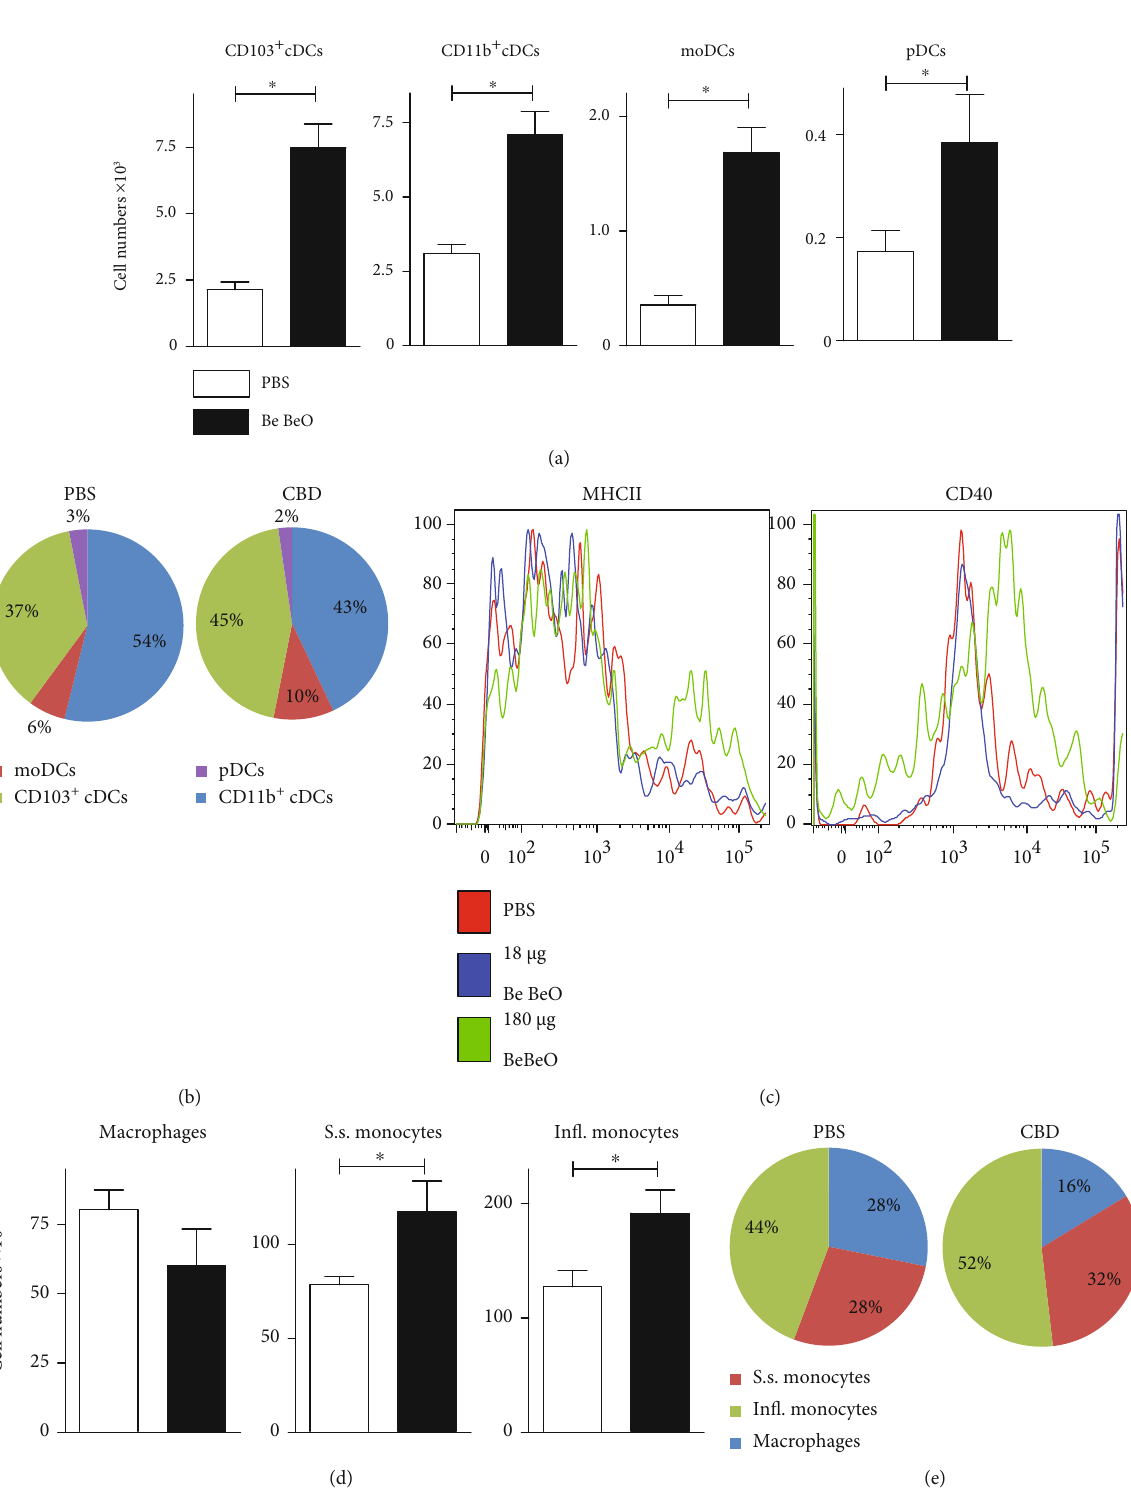
Figure 4: DC subset analysis in BAL fl uid of CBD mice. (a) Quanti fi cation of DC subset numbers in BAL of PBS-treated mice (white bars) and CBD mice (black bars) 8 weeks after initial exposure. (b) Pie charts showing proportions of DC subsets in BAL fl uid of PBS-treated and CBD mice. (c) DC activation as measured by fl ow cytometry staining of surface expression of MHCII and CD40 on gated CD11c + cells from the nonauto fl uorescent fraction. (d) Quanti fi cation of the indicated macrophage and monocyte fractions in BAL of PBS-treated mice (white bars) and CBD mice (black bars) (steady-state (S.s.) monocyte; in fl ammatory (In fl .) monocytes). Pie charts showing proportions of macrophage/monocytes in BAL fl uid of PBS-treated and CBD mice. Data are expressed as the means ± SEM (a, d) (Mann-Whitney U test: ∗ p < 0 : 05 ). Data are from n = 4 − 5 mice per group and representative for 2